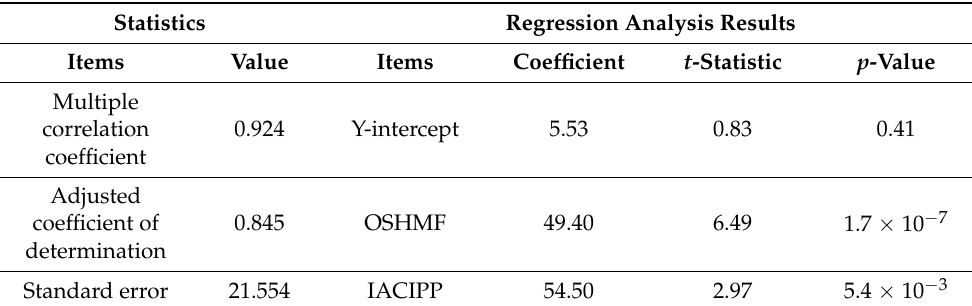
Figure 2. Plot showing the ratios of APC to total construction cost (TCC) of the 38 projects studied herein. Table 8. Multiple regression analysis